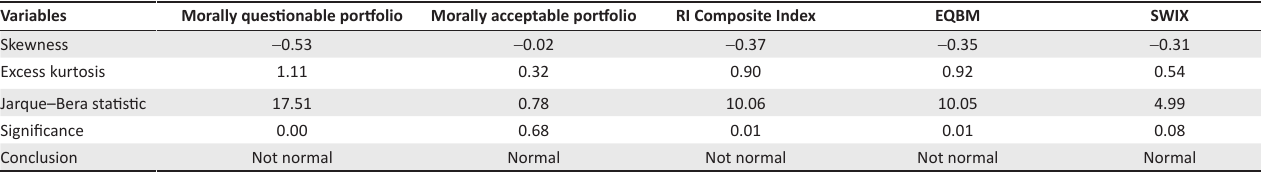
TABLE 2: Tests for normality of distributions. Variables